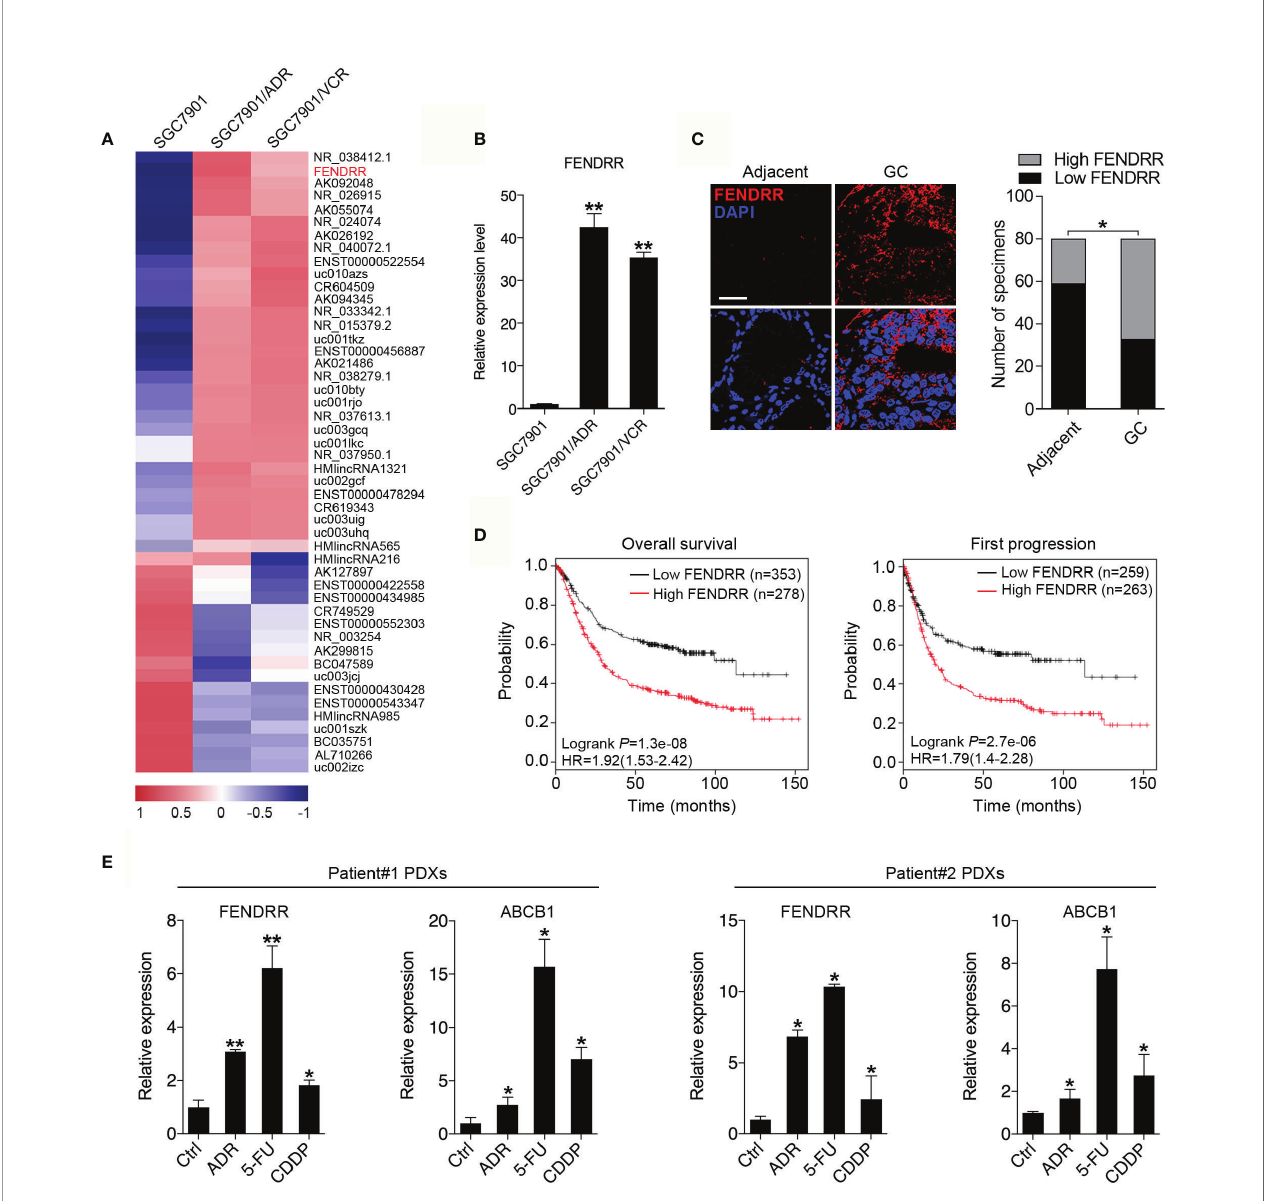
FIGURE 1 | Upregulation of FENDRR expression in GC tissues and multidrug-resistant cells indicates a poor prognosis (A) Heat map showing the lncRNAs with signi fi cantly increased or decreased expression in the multidrug-resistant GC cell lines SGC7901/ADR and SGC7901/VCR compared with the parental SGC7901 cells, as determined using an Agilent Human lncRNA microarray. The scale bar shows color-coded differences in expression from the mean. (B) qRT-PCR results showing the upregulation of FENDRR expression in SGC7901/ADR and SGC7901/VCR cells compared with SGC7901 cells. (C) Representative images of FISH assays for FENDRR (red) in 80 paired GC and adjacent normal tissue samples are shown. Scale bar, 50 m m. (D) Kaplan-Meier analysis was used to evaluate the correlation between FENDRR expression and overall (left) and fi rst progression (right) survival in patients with GC. (E) qRT-PCR was used to analyze FENDRR and ABCB1 expression in two drug resistant patient-derived xenografts (PDXs). ** P < 0.01, * P < 0.05. Data represent mean ± s.d. in (B, C, E)